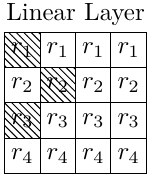
64-bit block size and a 64-bit tweakey. The state is divided in a 4x4 roster where each cell is a nibble. The S-box consists of a 4-bit cubic function and its linear layer consist of a ShiftRows and a MixColumns operation. More specifically, it uses a quasi-MDS MixColumns. The tweakey schedule from Skinny is linear and consists of a permutation and the application of a Linear Feedback Shift Register